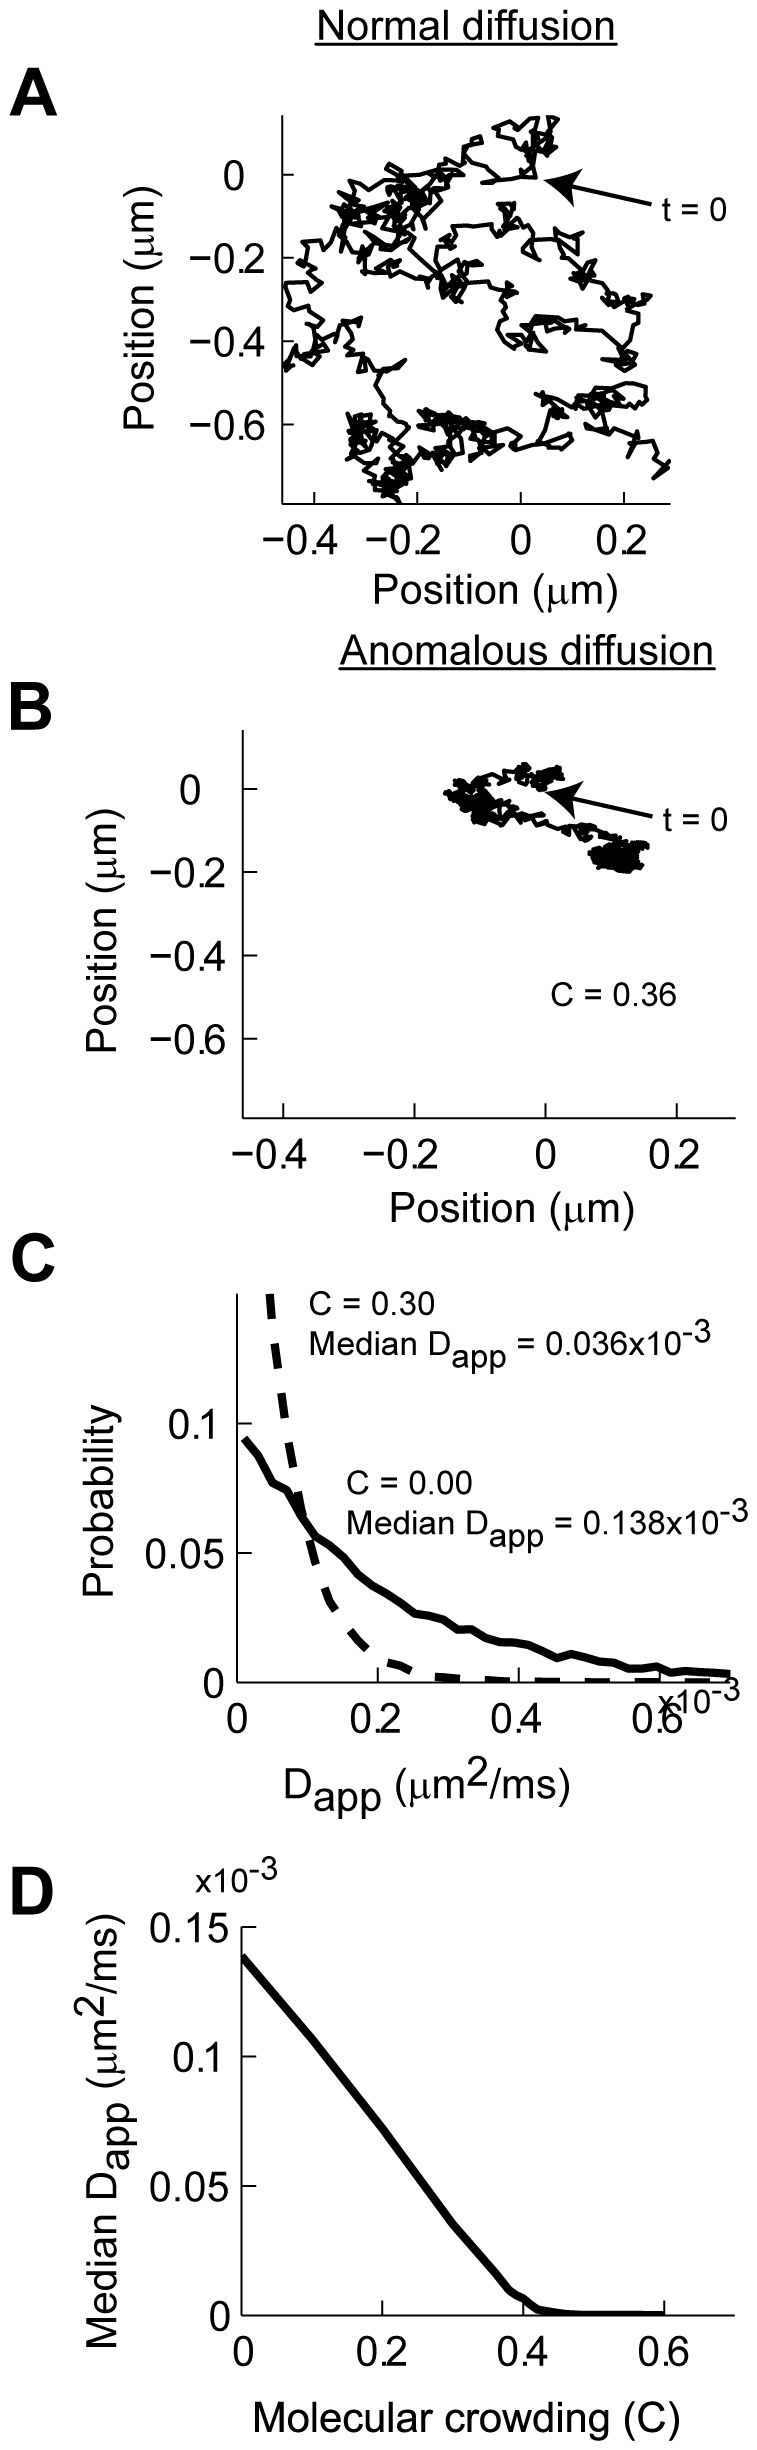
Molecular crowding affects the diffusion of AMPAR in the PSD.
A: An example of a trajectory of a simulated AMPAR in a membrane free of obstacles (C = 0.00). B: An identical simulation as in A with the same initialization of the random number generator for an AMPAR diffusing on a membrane covered by fixed PSD molecules with a molecular crowding of C = 0.30. C: The calculated histogram of apparent diffusion coefficients (Dapp) with no obstacles (C = 0, dashed line) results in a median value of Dapp = 0.138×10−3 µm2/ms. A similar curve calculated with C = 0.36 results in a median Dapp = 0.038×10−3 µm2/ms (solid line). D: Median Dapp as a function of molecular crowding calculated for all the simulations shown in Figure 1.